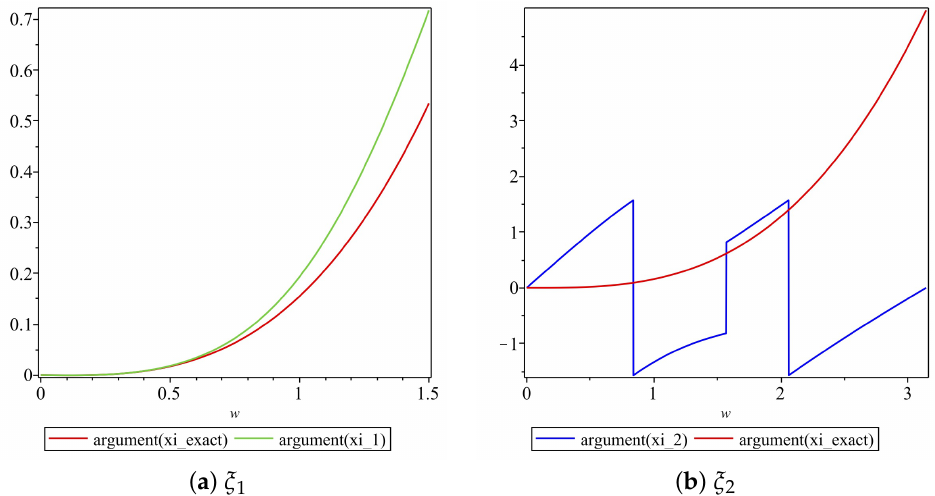
Figure 30. Plot of the arguments of amplification factors of Scheme 3 for Numerical Experiment 2 with the spatial and temporal step sizes are h = π /10 and k = 0.001,